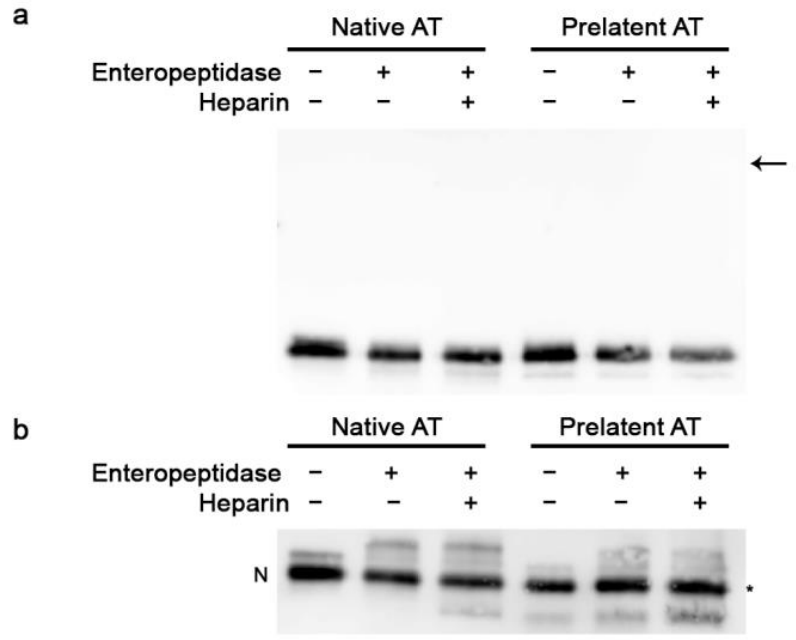
Figure 1. Electrophoretic evaluation of the interaction between antithrombin and enteropeptidase. SDS-PAGE was run under reducing (+dithiothreitol (DTT)) ( a ) and non-reducing ( − DTT) conditions ( b ), and Western blotting with immunodetection with anti-antithrombin antibody was performed. The asterisk represents cleaved antithrombin. N indicates the electrophoretic mobility in SDS for antithrombin in its native conformation. The arrow represents the covalent complex expected for antithrombin–enteropeptidase (~90 kDa). AT: antithrombin.